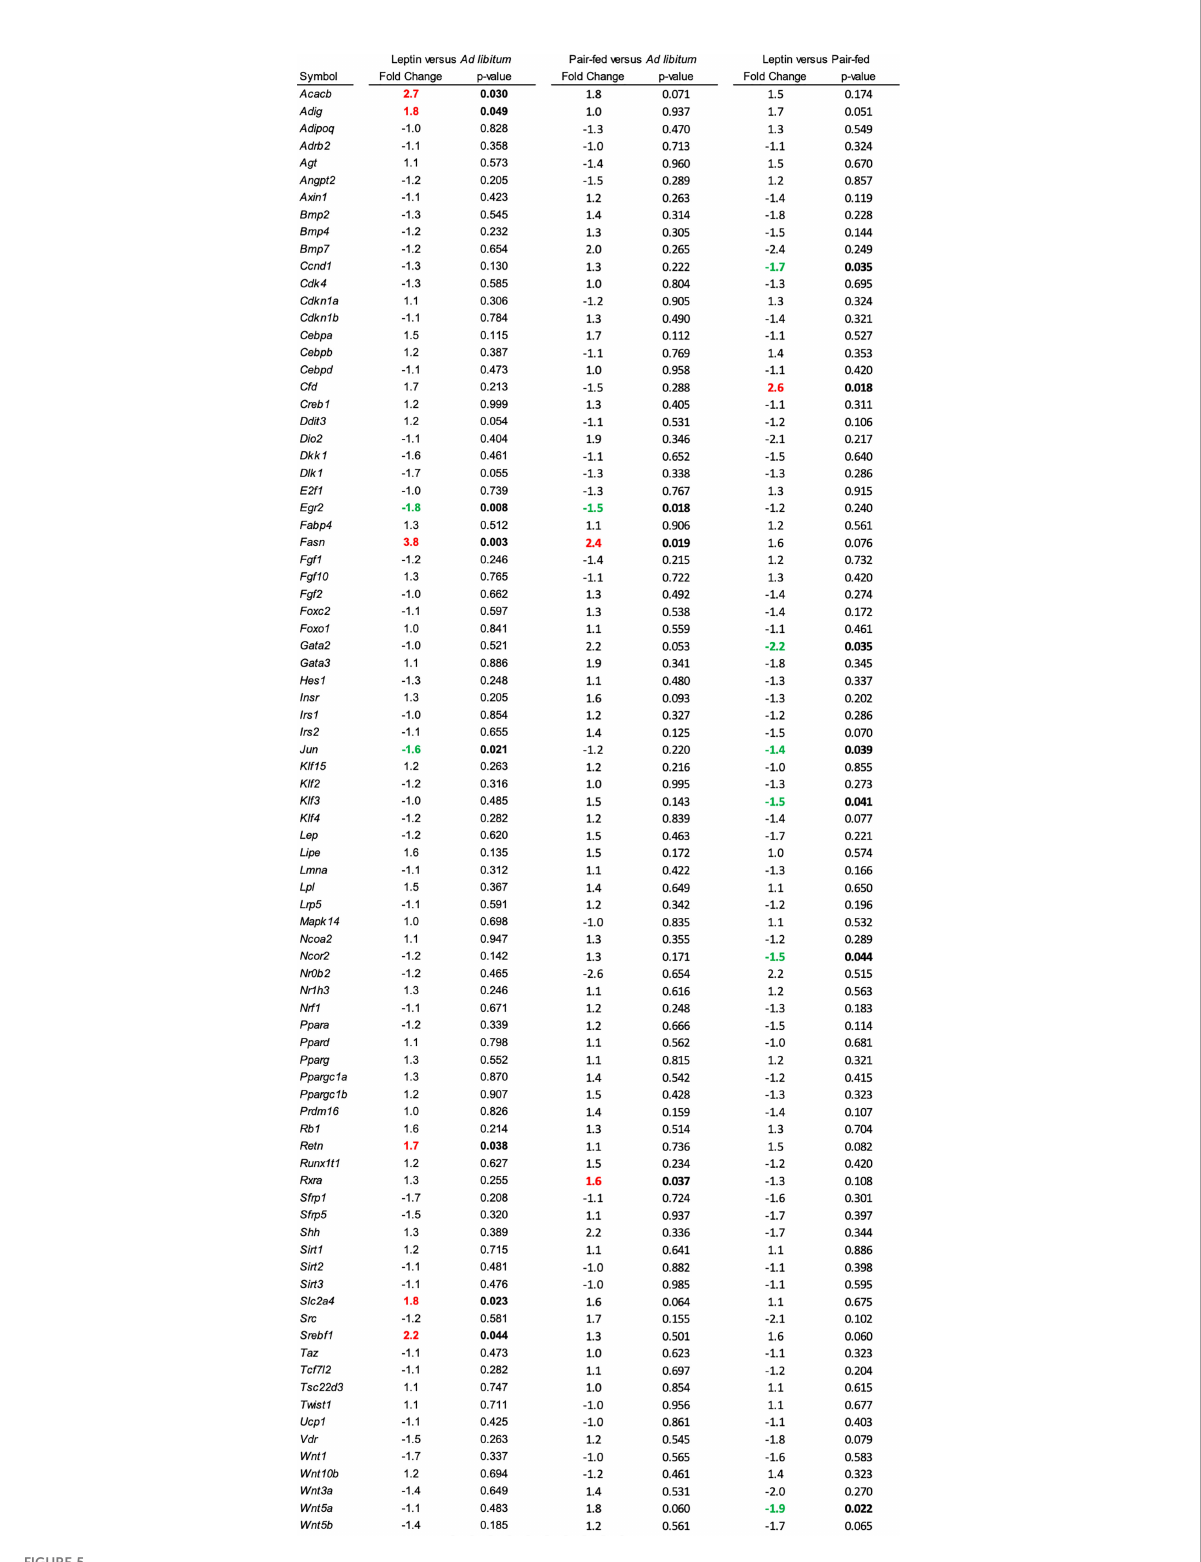
FIGURE 5 Differentially expressed genes in abdominal white adipose tissue in (1) leptin-supplemented versus ad libitum control mice, (2) pair-fed versus ad libitum control mice, and (3) leptin-supplemented versus pair-fed